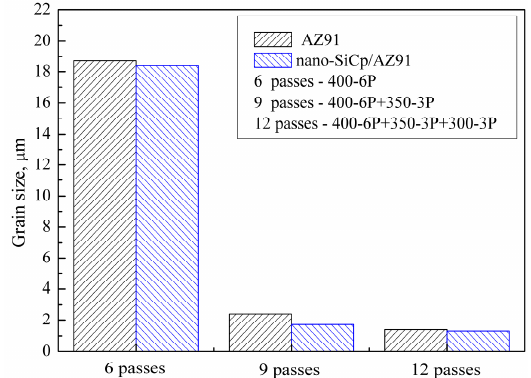
Figure 2. Grain sizes of AZ91 alloy and nano-SiCp/AZ91 composites after multi-pass forging for different